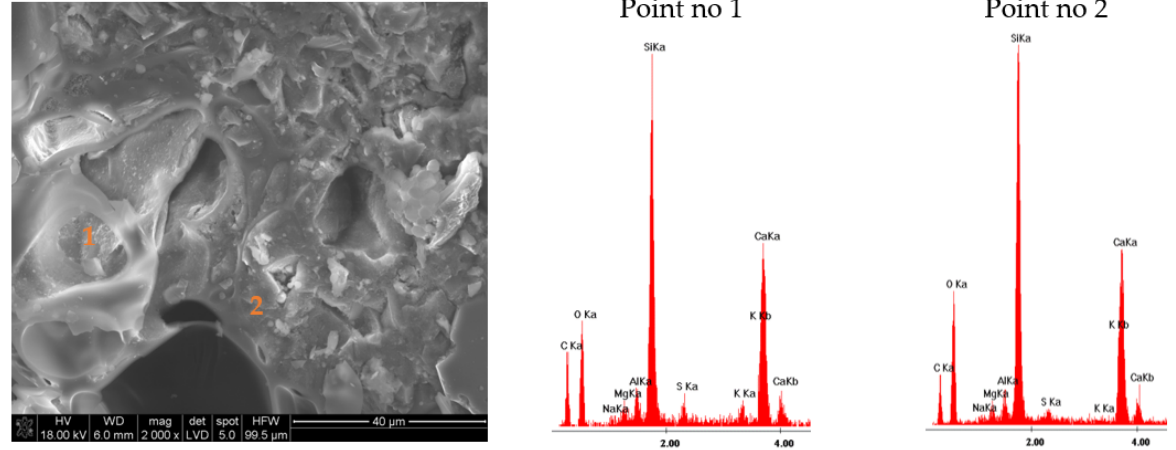
Figure 10. Microstructure of lightweight RPC with 30 vol.% of EP, cured for 28 days in 2000 times magnification with EDS analysis in point 1 and 2.